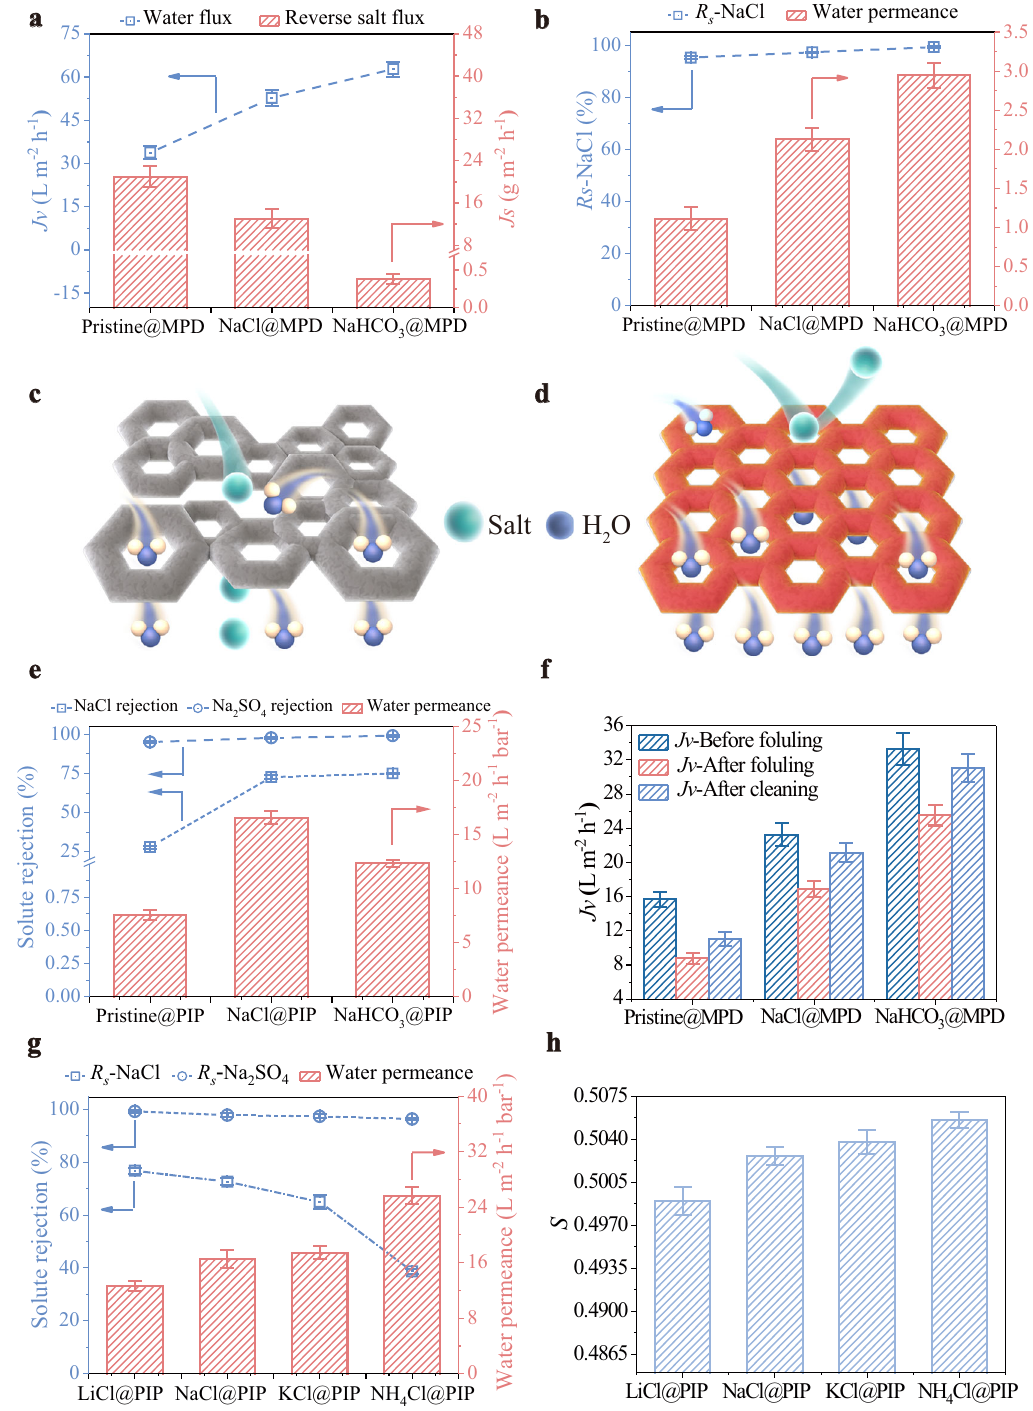
Fig. 5 Separation and antifouling properties of the pristine and modi fi ed membranes. a Water fl ux ( Jv ) and reverse salt fl ux ( Js ) of the pristine and modi fi ed membranes formed by MPD and TMC applied in FO process, under PRO mode using DI water and 2 M NaCl solution as the feed and draw solutions. b Water permeance ( A ) and NaCl rejections ( Rs -NaCl) of the pristine and modi fi ed membranes formed by MPD and TMC using 1000 ppm NaCl solution as the feed applied in RO separation. Schematic illustrations about PA layers of c modi fi ed and d pristine membranes. e Water permeance ( A ) and solute rejections ( Rs ) of the pristine and modi fi ed membranes formed by PIP and TMC using 1000 ppm NaCl or Na 2 SO 4 solution as the feed applied in NF process. f Dynamic fouling test results of the pristine and modi fi ed membranes formed by MPD and TMC in FO process. g Water permeance ( A ) and NaCl rejections ( Rs -NaCl) of various salt-modi fi ed membranes formed by PIP and TMC using 1000 ppm NaCl or Na 2 SO 4 solution as the feed applied in NF process. h S values of various salt-modi fi ed membranes formed by PIP and TMC. The error bars represent the standard deviation and were calculated on the basis of at least three data points measured from different